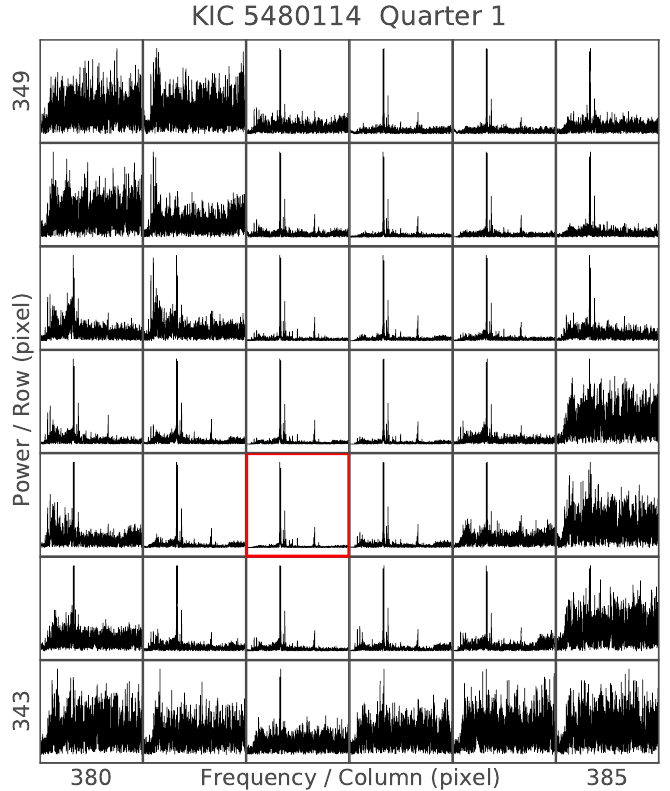
Figure 5. Pixel-level frequency spectrum for KIC 5480114. The red box shows the position of the target